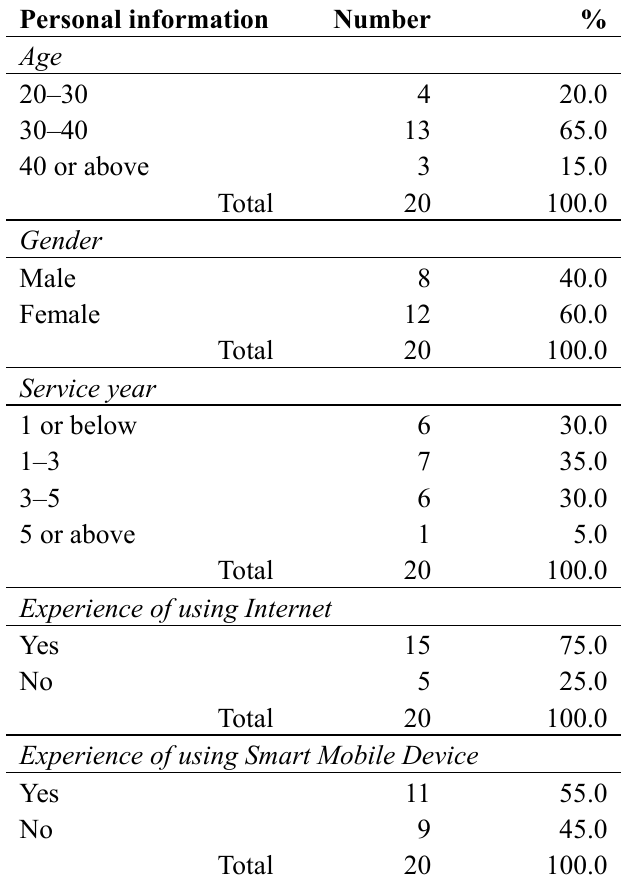
Table 3. User profiles